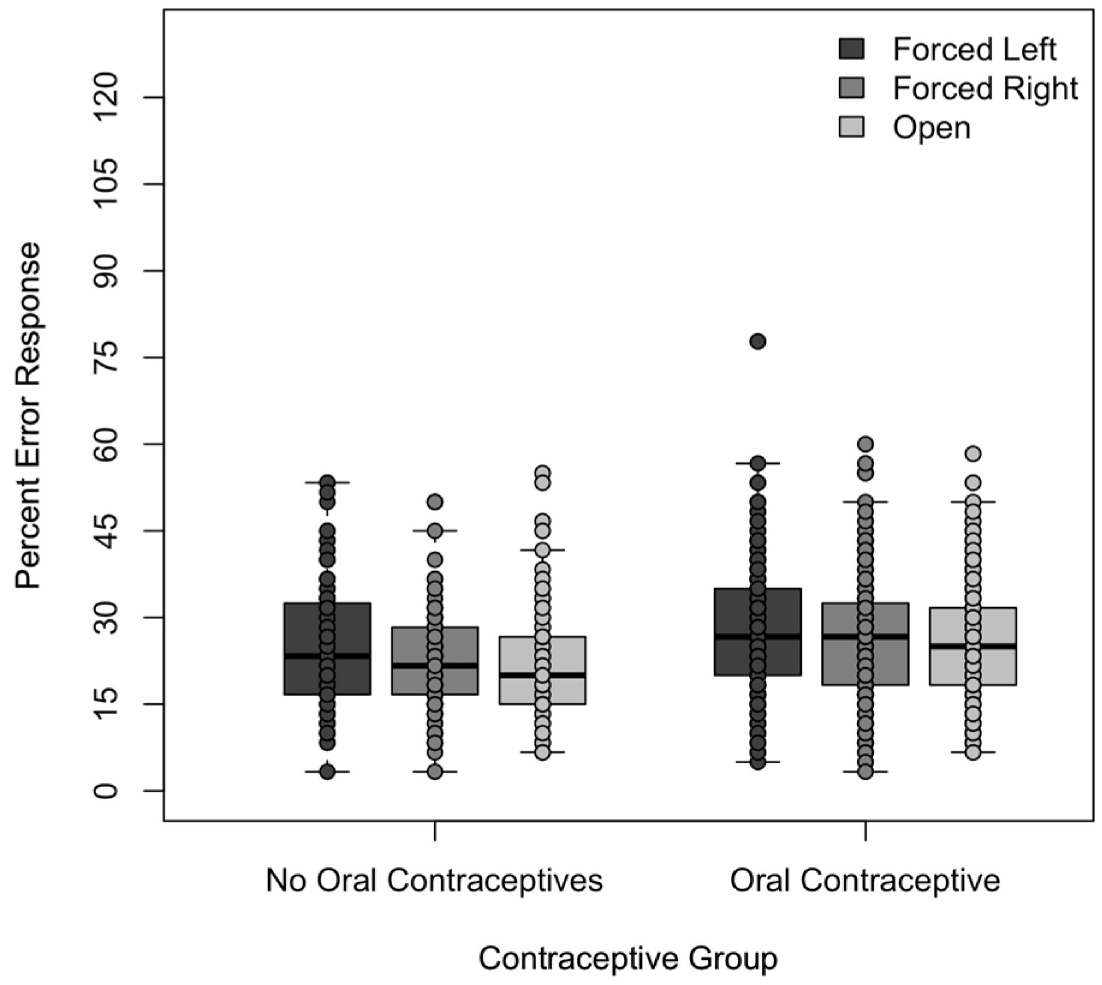
Fig 3. Percentage of error responses under the three listening conditions to the two listening groups. Percentage of error responses under the forced left, forced right, and open conditions by the women not taking oral contraceptives and those taking oral contraceptives.